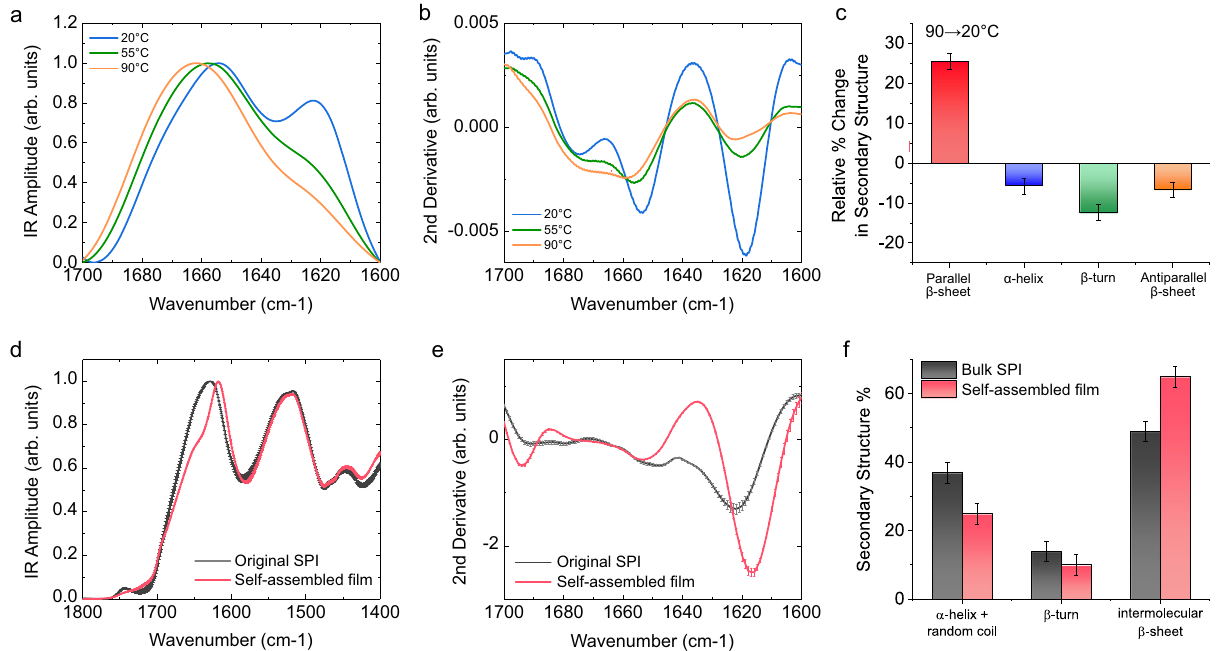
Fig. 2 Secondary structure analysis of SPI self-assembly. a , b ATR-FTIR spectra of SPI solution during cooling down from 90 to 20 °C ( a ) and their second derivatives ( b ). c Relative change in the secondary structure during cooling down from 90 to 20 °C. d , e ATR-FTIR spectra of original SPI powder and the dried self-assembled fi lm ( d ) and their second derivatives ( e ). f Quanti fi cation of secondary structure content calculated from Amide I band of IR spectra for original SPI powder and the dried self-assembled fi lm. The indicated error bars are the s.d. of the average of three different spectra, each one is co-average of 256 scans.